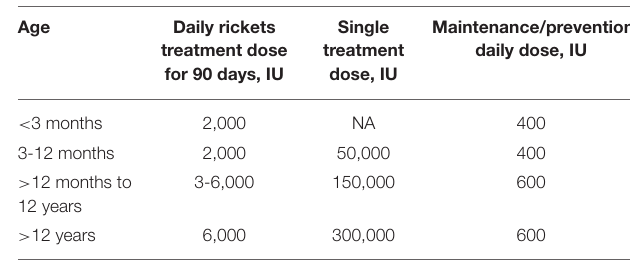
TABLE 1 | Suggested vitamin D (cholecalciferol) doses for the prevention and treatment of nutritional rickets in children